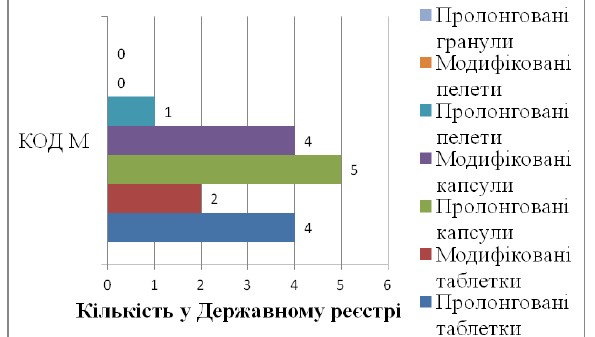
Рис. 7. Кількісна представленість ТОЛЗВД у Державному реєстрі (код M – Лікарські засоби для лікування захворю- вань кістково-м’язової системи)